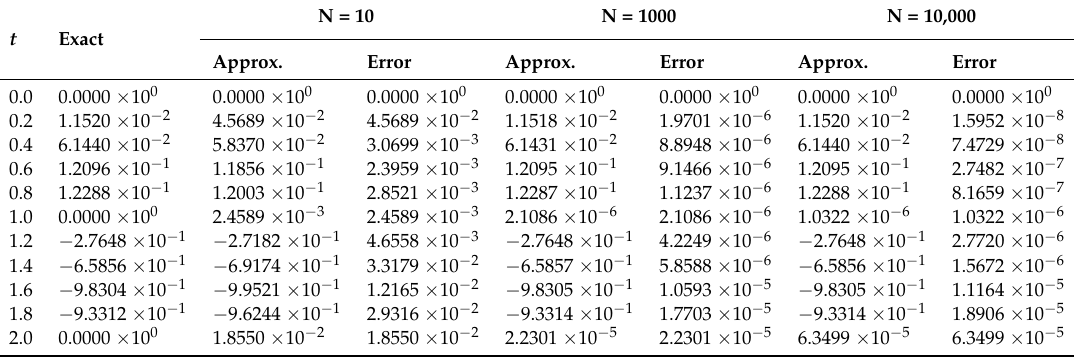
Table 9. Approximate solutions and absolute errors at each point, t when α = 1.50 for solving Example 5 by using FEAM3 at different intervals, N